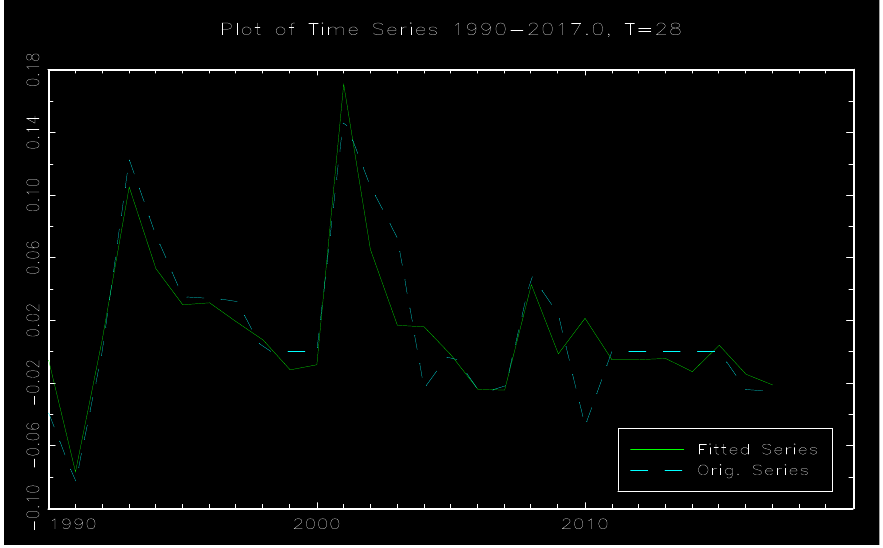
Figure 3. Original and fitted data time series diagram.